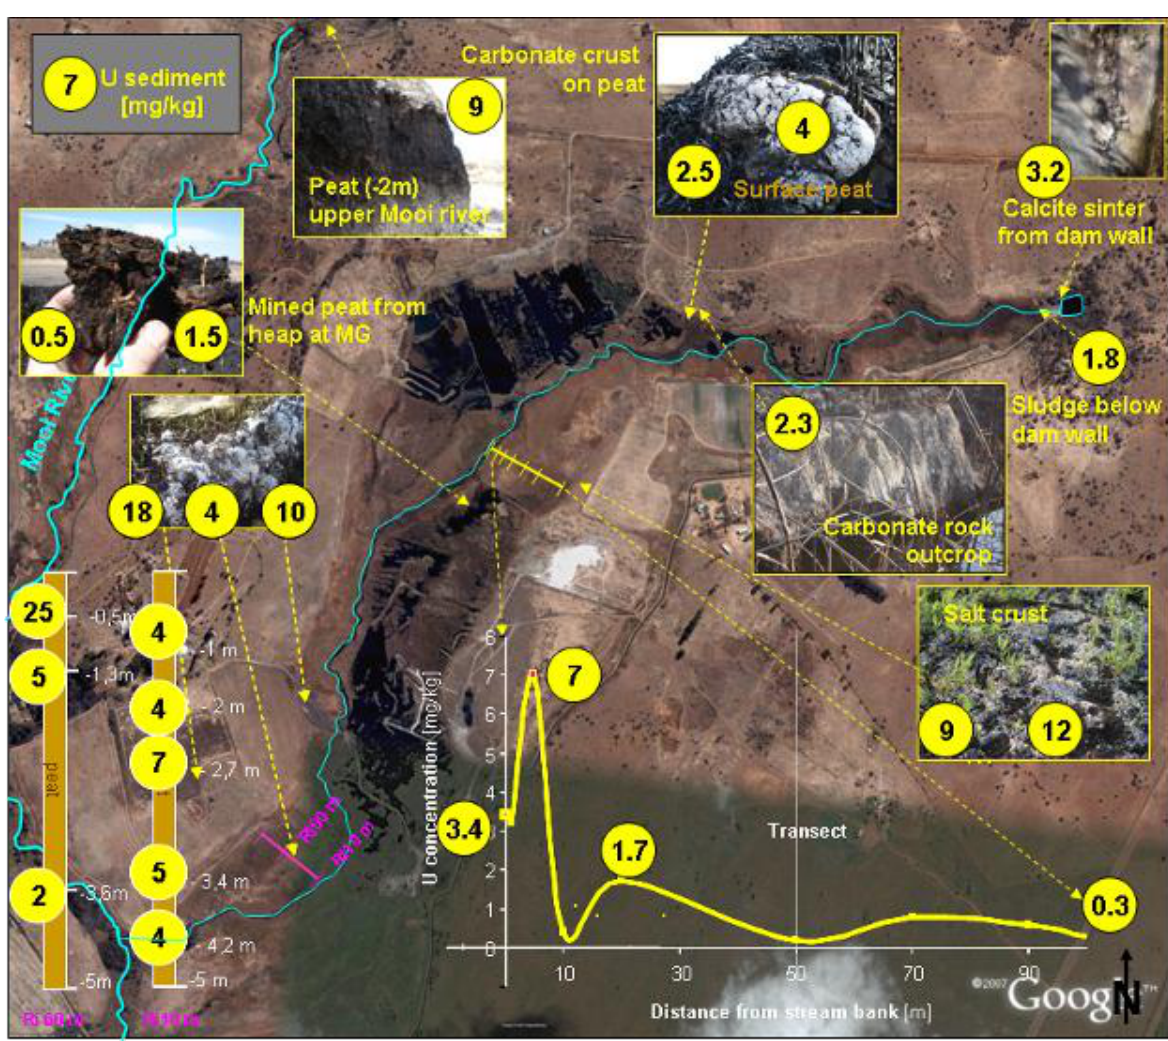
Figure 7. U concentration in different types of sediments of the Gerhard Minnebron Wetland as found in screening survey (grab samples) (map based on satellite image of the study area as retrieved from Google